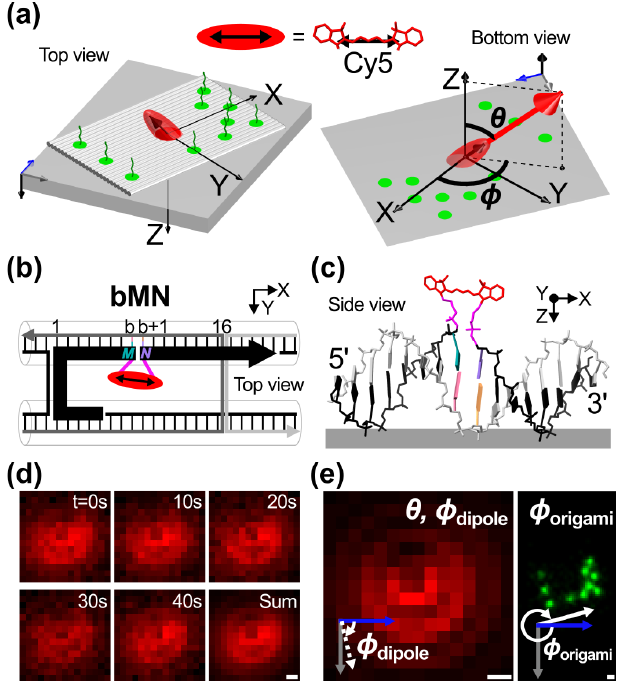
Figure 1. Spatial orientation of a single Cy5 relative to the DNA origami template using dipolar imaging and DNA-PAINT. ( a ) Left: schematic of the template on the glass substrate. Red ellipsoid and green circles represent Cy5 and docking sites for DNA-PAINT imagers, respectively. The TDM of the dye is depicted as the double-headed arrow inside the ellipsoid. Right: Bottom view through the glass. The TDM orientation is given by the polar ( θ ) and azimuthal ( φ ) angles relative to the template. ( b ) Inset of the design of the template. A segment of the scaffold (thin black strand) is replaced by a Cy5-internally-labeled DNA (thick black strand) that is complementary to the dark grey staple. Cy5 is placed b number of bases from a common crossover. The position of the Cy5 was changed by tuning the sequences of the dark and light grey staples while keeping the same bases, including the M and N flanking bases. A general sample was named bMN . The replaced segment of the scaffold is not shown. ( c ) Schematics of the molecular structure of the dye tethered to the DNA duplex on glass. Both tethers are shown in pink. Neighboring bases are shown in different colors. ( d ) Representative frames of the dipole radiation pattern of 8TT ( b = 8 , M = T , N = T ). Each frame was acquired for 2 s. Frames were summed to improve the signal-to-noise ratio. ( e ) Left: Simulated dipole radiation pattern with θ dipole (=35 ◦ ) and φ dipole (=77 ◦ ) at 550 nm defocused distance obtained after fitting the summed frame in ( d ). Right: DNA origami orientation, φ origami (= 345 ◦ ), was obtained relative to the camera coordinates after DNA-PAINT reconstruction. The dye orientation was obtained as θ = θ dipole and φ = φ dipole - φ origami . The Cartesian coordinates of the origami and glass are the XYZ axes and the unlabeled blue, grey, and black arrows. Scale bars for the images of dipole radiation patterns and DNA-PAINT reconstruction are 200 nm and 10 nm,